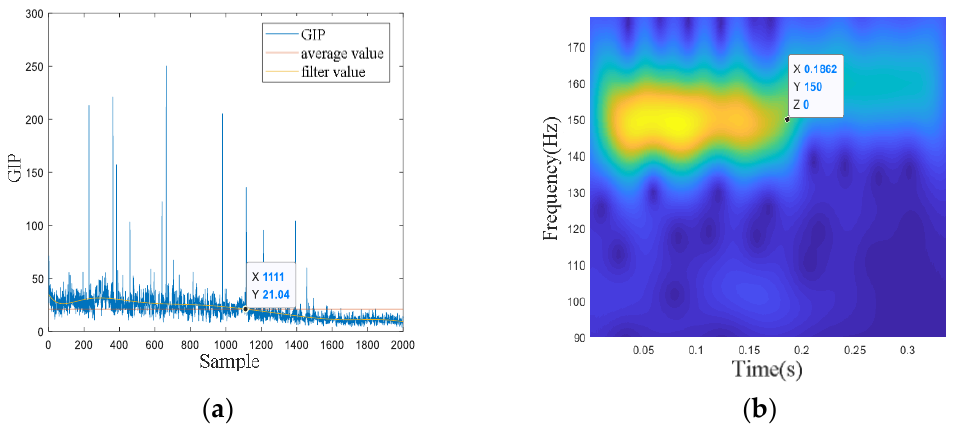
Figure 12. ( a ) Sample generalized inner product value; ( b ) time – frequency analysis result.